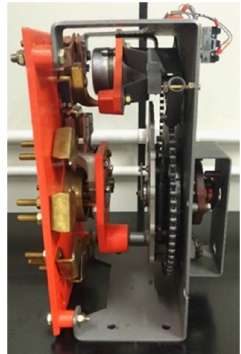
Figure 2. New on-load contact-changer CTR-3 Toshiba.